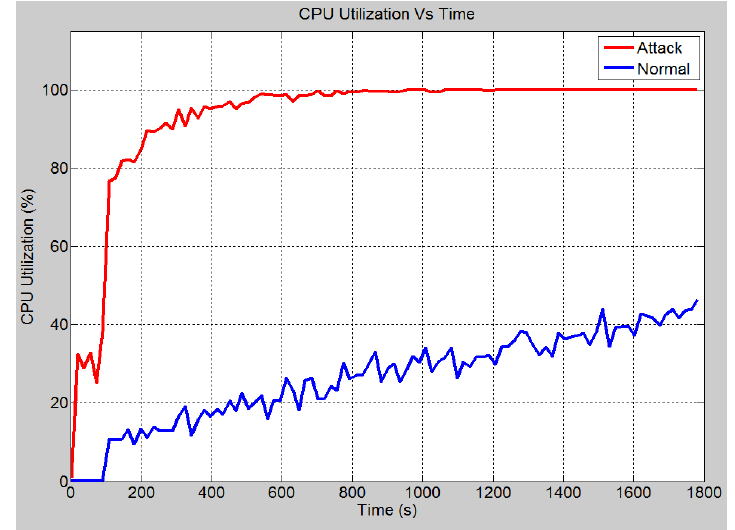
Figure 15. Case 3: IED CPU utilization rate (%).